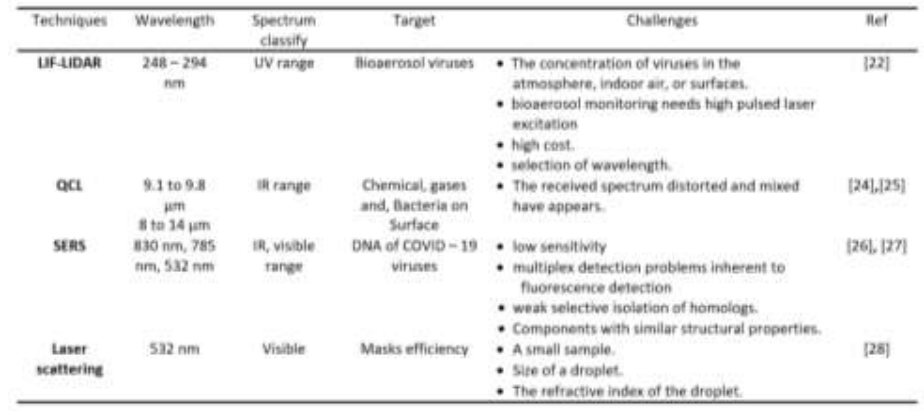
Table 1. Studies of Laser diagnosis of viruses